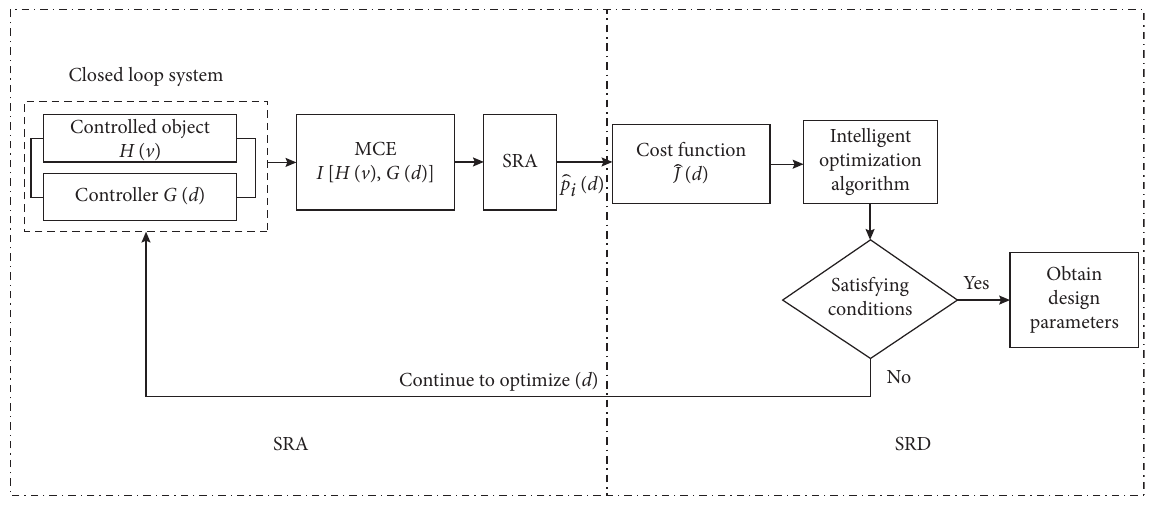
Figure 3: The stochastic robust optimization method. Table 1: Uncertain parameters and their distribution range. Uncertainty